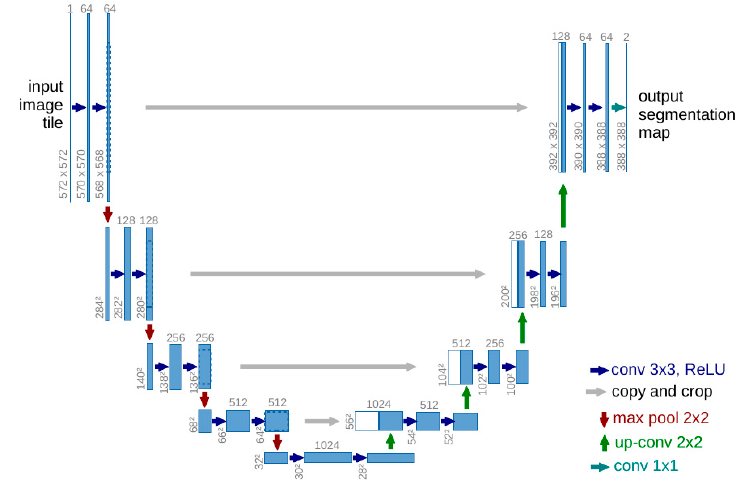
Figure 6. The original U-Net architecture [22].